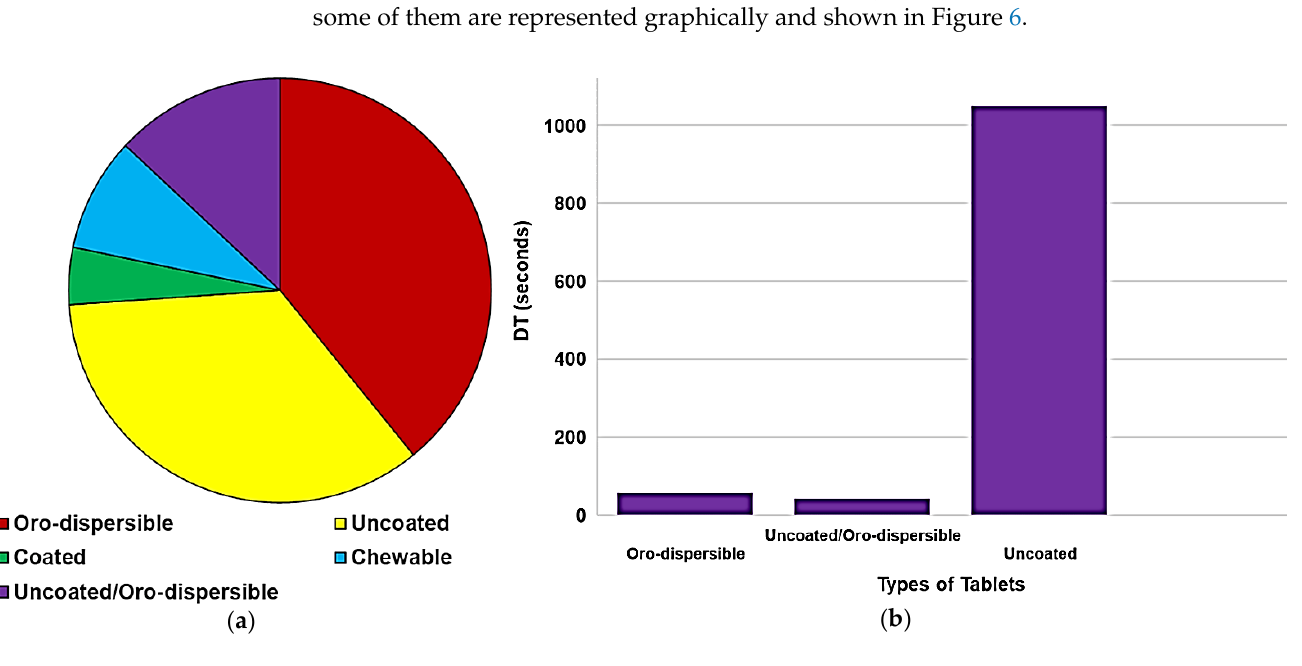
Figure 6. Distribution of the main typologies of the developed mini- and micro-tables formulations ( a ); ( b ) average DT values of oro-dispersible, uncoated/oro-dispersible and uncoated micro- and mini-tablet formulation reported in Table 5.